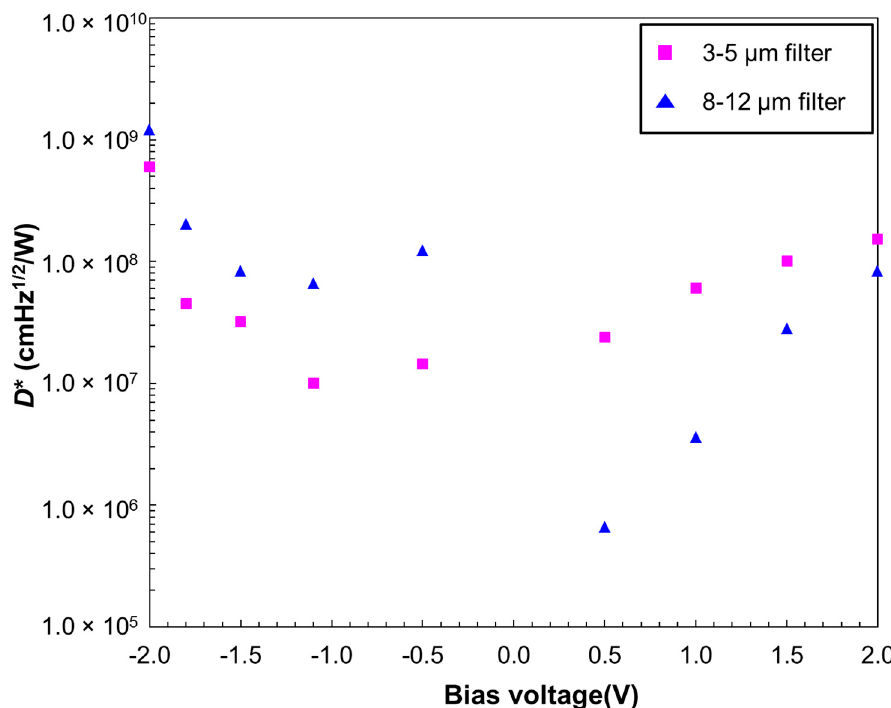
Figure 7. Calculated photodetectivity ( D* ) at different bias voltages with the 3–5 µm (square) and 8–12 µm (triangle) band pass filters. The 8–12 µm band has a higher D* at negative biases, whereas the photodetectivity D* of the 3–5 µm band is higher at positive biases.